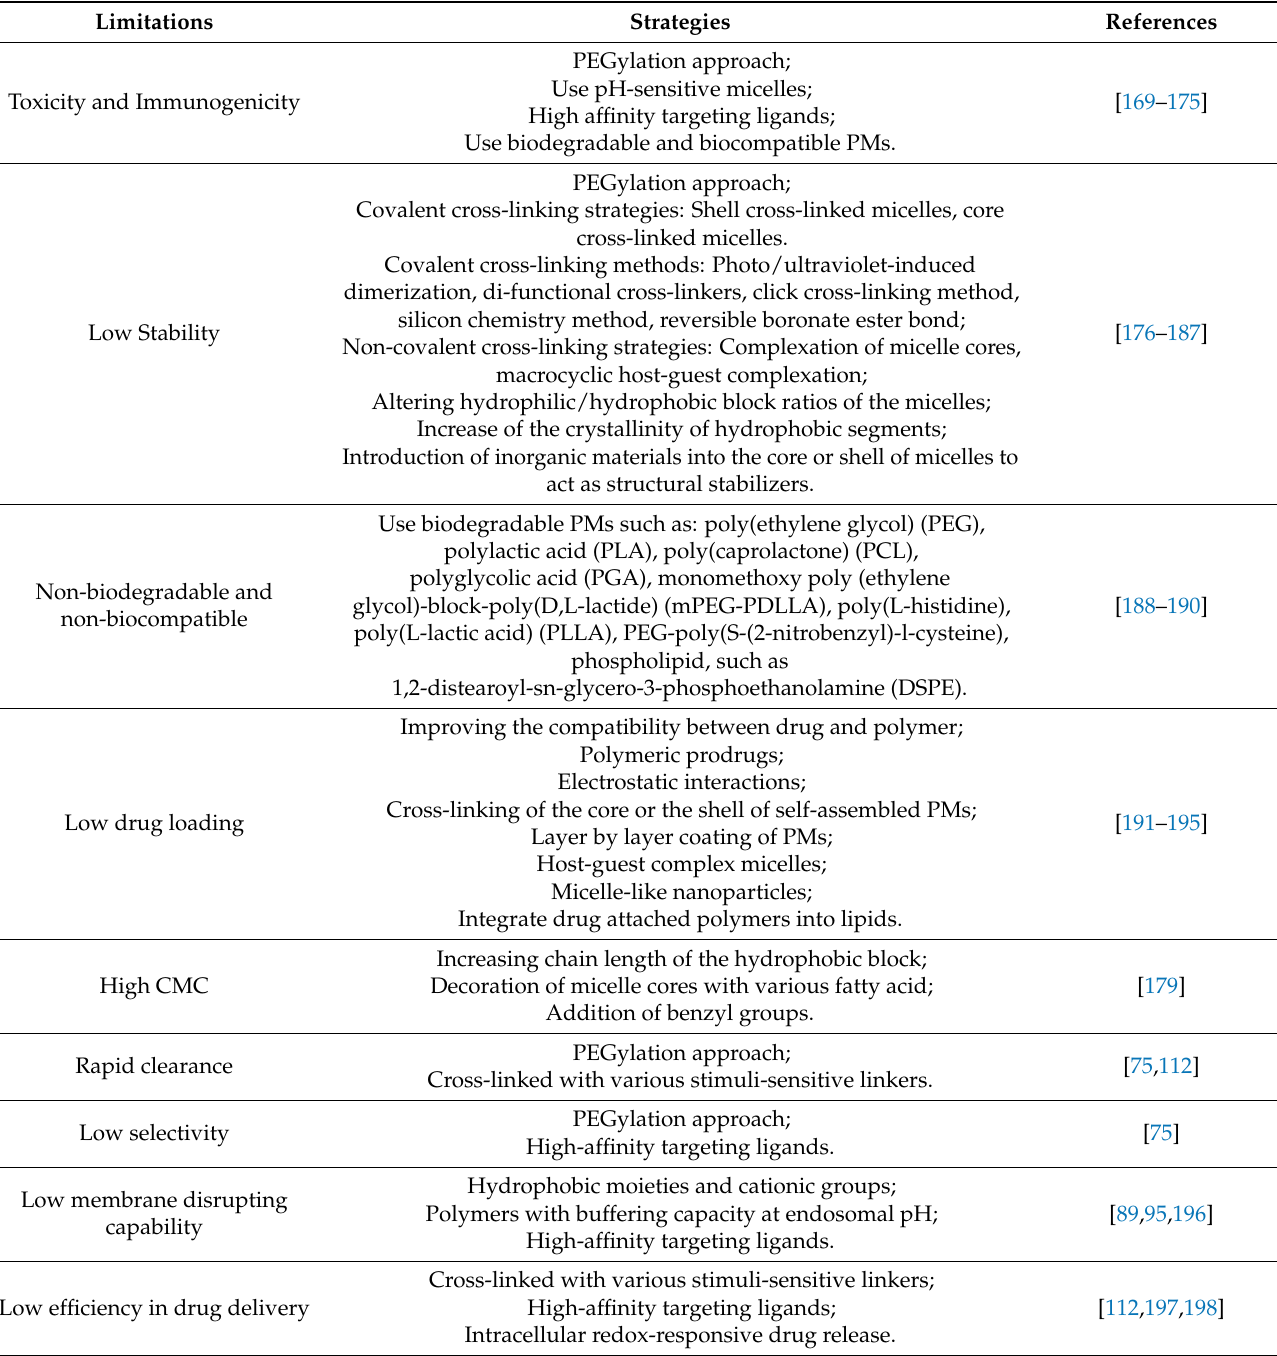
Table 4. Strategies to overcome the limitations related to the application of polymeric